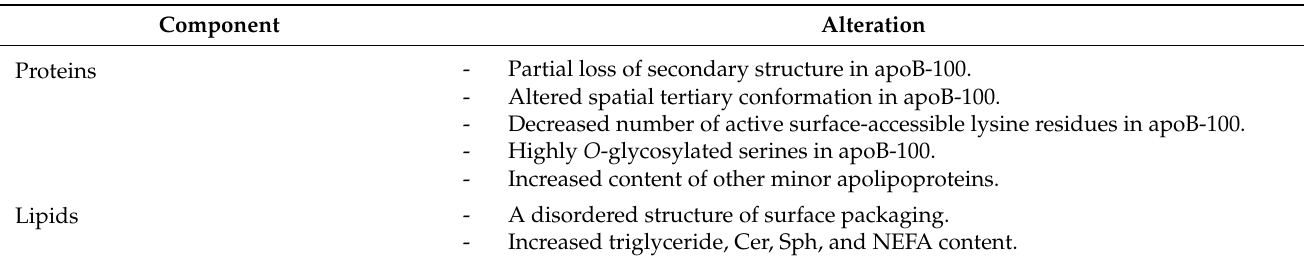
Table 2. Summary of structural alterations in LDL( −